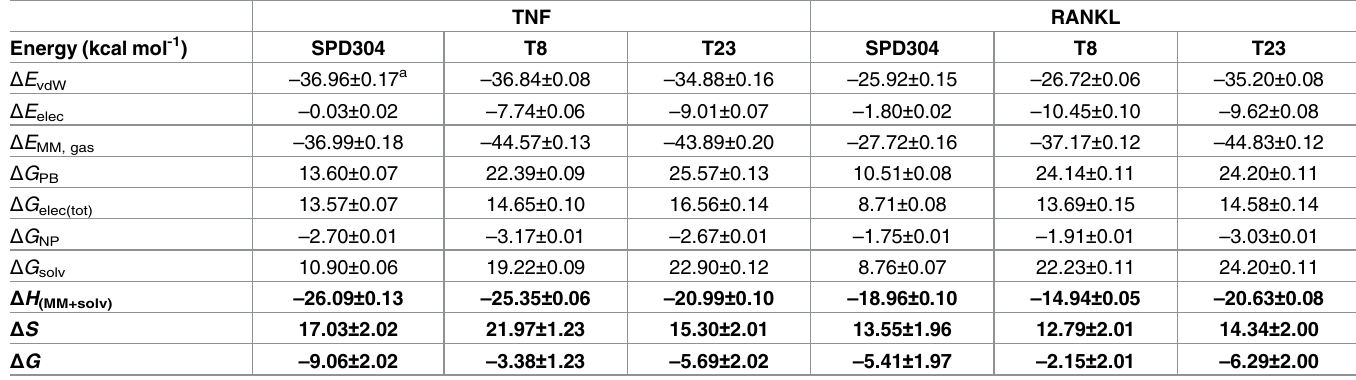
Table 5. Energetic analysis for TNF and RANKL complexes with compounds SPD304, T8 and T23, as obtained by MM–PBSA calculations.